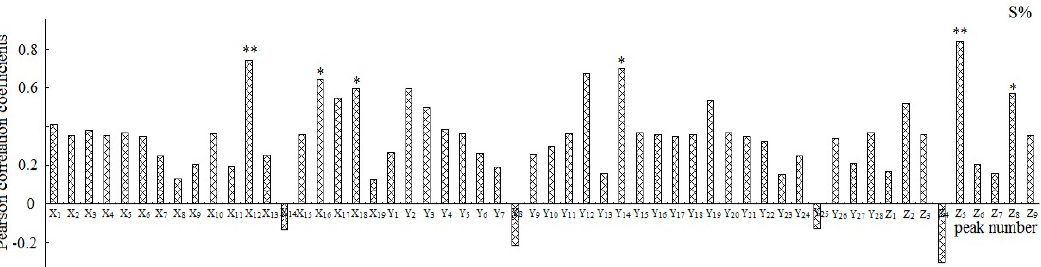
Figure 5. Pearson correlation coefficients between the variables and pharmacologic data S%. **: p < 0.01, *: p < 0.05; S% was the survival extension rate.